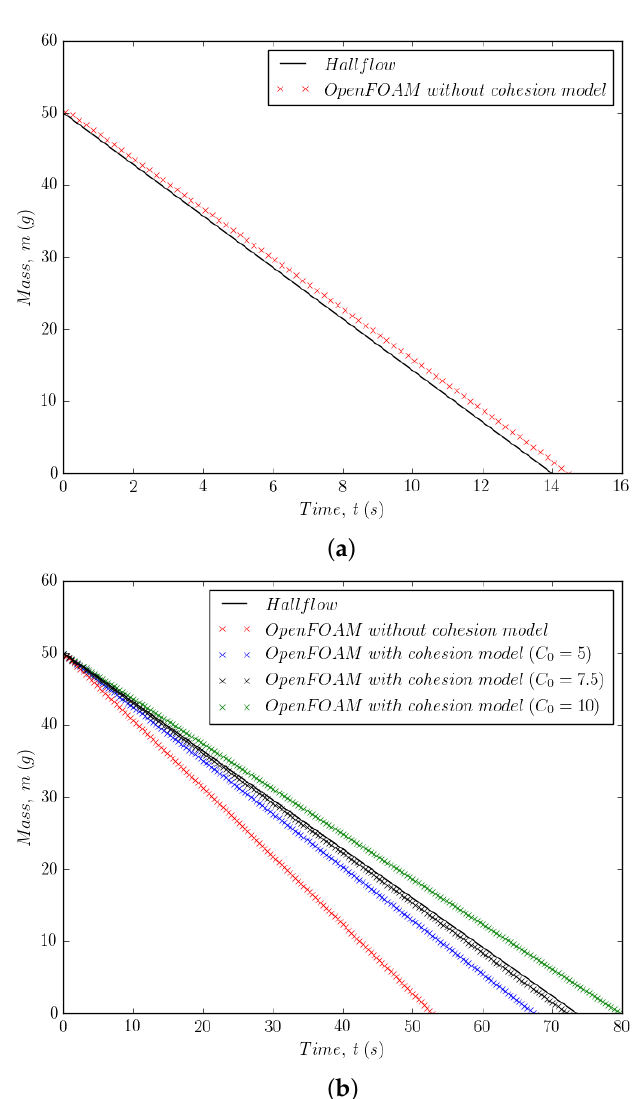
Figure 2. Comparison between the Eulerian–Eulerian model and the Hallflow experimental data. ( a ) Results for Inconel (Geldart Type B) without cohesive force model. ( b ) Results for aluminium powder (Geldart Type A) with different values of C 0